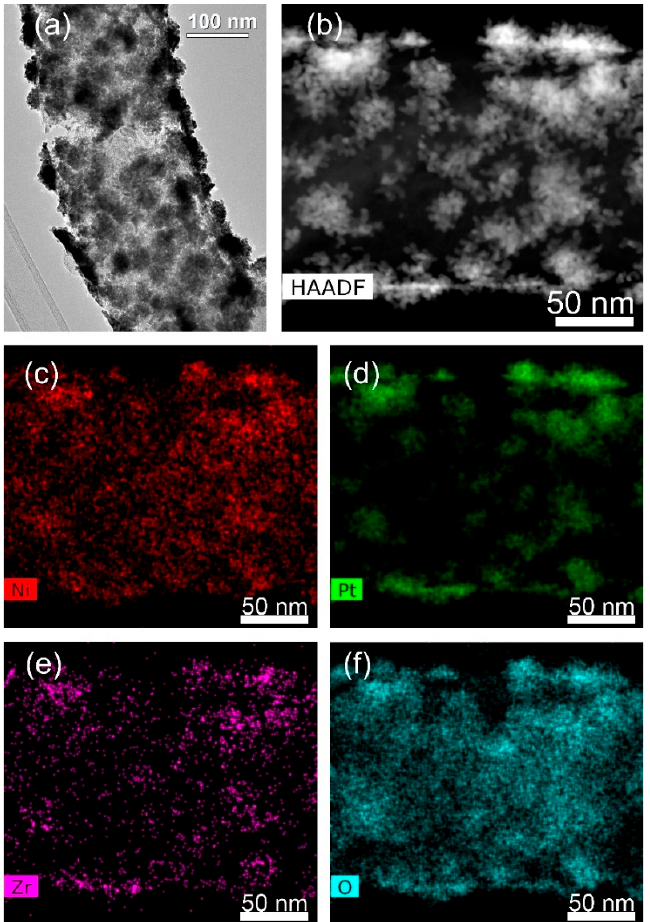
Figure 13. Elemental distribution on the surface of the CNF fragment (sample 9 ): ( a ) STEM HAADF image; ( b – f ) corresponding elemental maps.